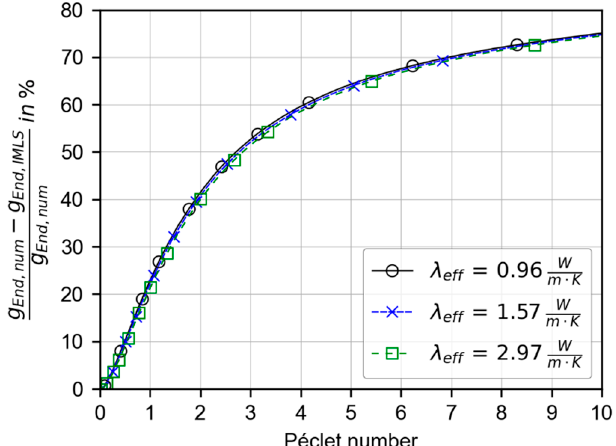
Figure 6. Percentage deviation of the g-functions depending on the Péclet number for different effective thermal conductivities.